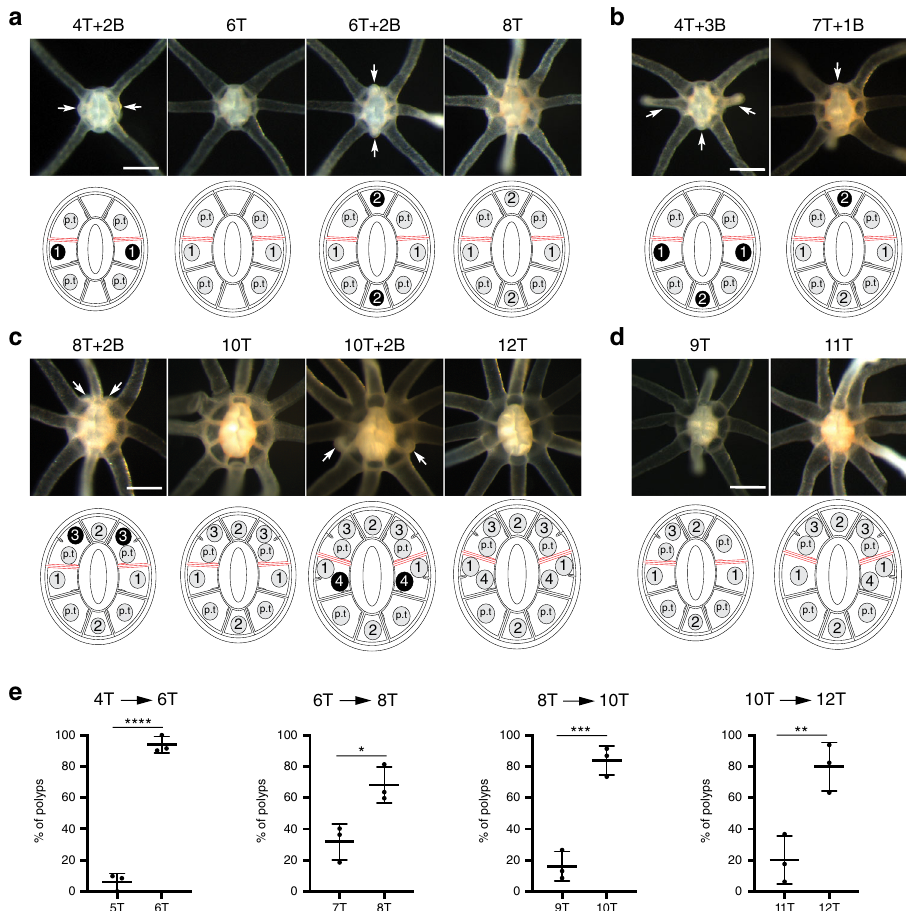
Fig. 2 Phases I and II of tentacle addition. a , b Oral views of fed polyps progressing from four to eight tentacles. a Polyps showing the dominant budding patterns. Polyps with four-tentacles and two buds (4 T + 2B, n = 64), six-tentacles (6 T, n = 88), six-tentacles and two buds (6 T + 2B, n = 31), and eight-tentacles (8 T, n = 67). b Alternative budding patterns. Polyps with four-tentacles and three buds (4 T + 3B, n = 17), and seven-tentacles and one bud (7 T + 1B, n = 6). c , d Oral views of fed polyps progressing from 8 to 12 tentacles. c Dominant budding patterns. Polyps with 8-tentacles and two buds (8 T + 2B, n = 37), 10-tentacles (10 T, n = 107), 10-tentacles with two buds (10 T + 2B, n = 42), and 12-tentacles (12 T, n = 223). d Polyps with 9-tentacles (9 T, n = 29) and 11-tentacles (11 T, n = 69). White arrows show the sites of budding events. All data are from three independent experiments. Scale bars are 250 μ m in all micrographs. Diagram showing tentacle arrangement is provided under each image. Tentacles and buds are depicted as gray and black discs, respectively. The numbers inside the discs indicate the sequence of budding. The positions of primary tentacles (p.t) are shown. e Quanti fi cation of tentacle number including buds in polyps from three independently growing groups (the number of polyps in each group are n = 334, n = 315, and n = 175). Tentacle progression is indicated on the top of each graph and the numbers of analyzed polyps are indicated. For all the graphs, data are mean ± SD for error bars (unpaired Student ’ s two-tailed t -test, * p < 0.05, ** p < 0.01, *** p < 0.001, **** p < 0.0001). Source data are provided as a Source data fi